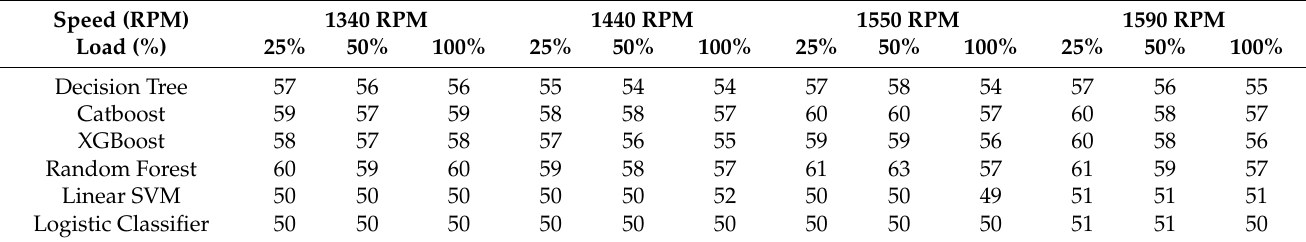
Table 7. Summary of the validation accuracy using terminal signals in different operating